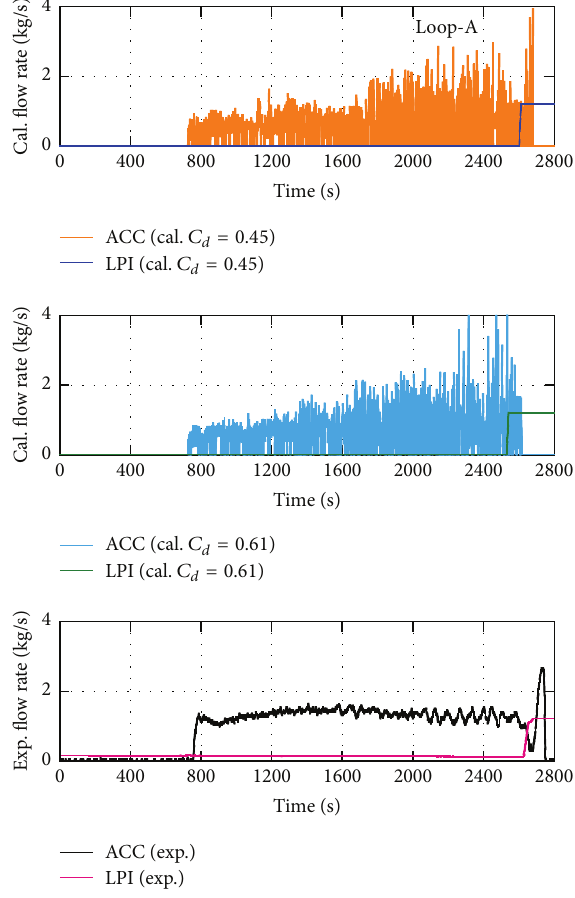
Figure 20: LSTF and RELAP5 results for flow rates of ACC and LPI systems in loop-A in case of no release of dissolved